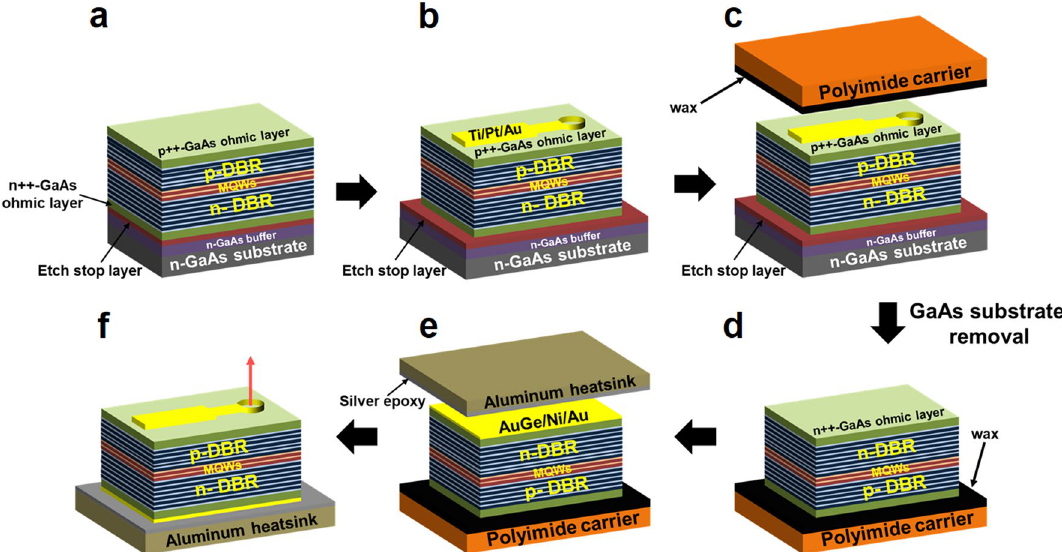
Figure 3. Double transfer technique to transfer the thin-film VCSELs onto aluminum heatsink. ( a ) P-on-n structures of thin-film 940-nm VCSELs are epitaxially grown in upright order via MOCVD. ( b ) The mesa etching is carried out by selectively removing the multiple layers of p- and n-DBR, and MQWs in order to isolate the VCSELs. Then, p-ohmic metal with a combination of Ti/Pt/Au is deposited on the highly p-doped GaAs layer. The 10-μm oxide-confined aperture size of each VCSEL was defined with selective oxidation of Al x Ga 1-x As with high Al contents. ( c ) An adhesive wax is used for bonding the thin-film VCSELs to the polyimide carrier. ( d ) The etch stop layer is etched by acid solution after removing the 350-μm n-GaAs substrate in the NH 4 OH- based etchant. ( e ) The silver epoxy is uniformly applied on the aluminum heatsink, which is integrated with the wax-bonded thin-film VCSELs. ( f ) Top-emitting 940-nm thin-film VCSELs are successfully fabricated onto an aluminum heatsink after separating the thin-film VCSELs from the polyimide